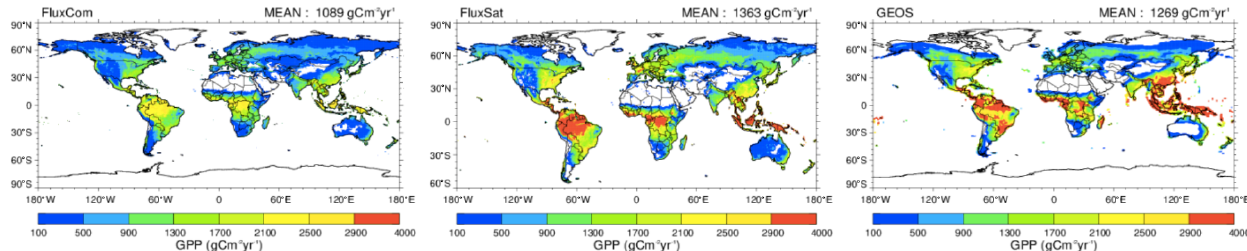
Figure 5. 2010–2015 multiyear average global GPP from FluxCom, FluxSat, and GEOS. The global average value is shown at the top.